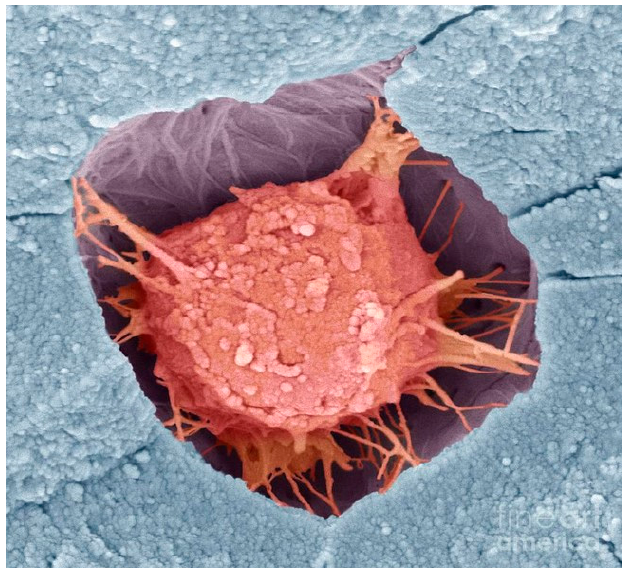
Figure 2. A photomicrograph of an osteocyte embedded in its lacuna. Evolved from osteoblasts entrapped in bone matrix, osteocytes form a multitude of dendritic extensions that communicate with osteoblasts, osteoclasts, and other osteocytes through a network of channels cut into the bone matrix. These dendritic extensions are sensitive to pressure changes associated with mechanical loading and unloading and allow osteocytes to regulate the balance between bone absorption and bone formation. Osteocytes undergo apoptosis in zero gravity, losing their control over bone homeostasis, and secrete sclerostin, a mechanosensitive protein that inhibits bone formation and enhances bone resorption (photograph by Steve Gschmeissner).